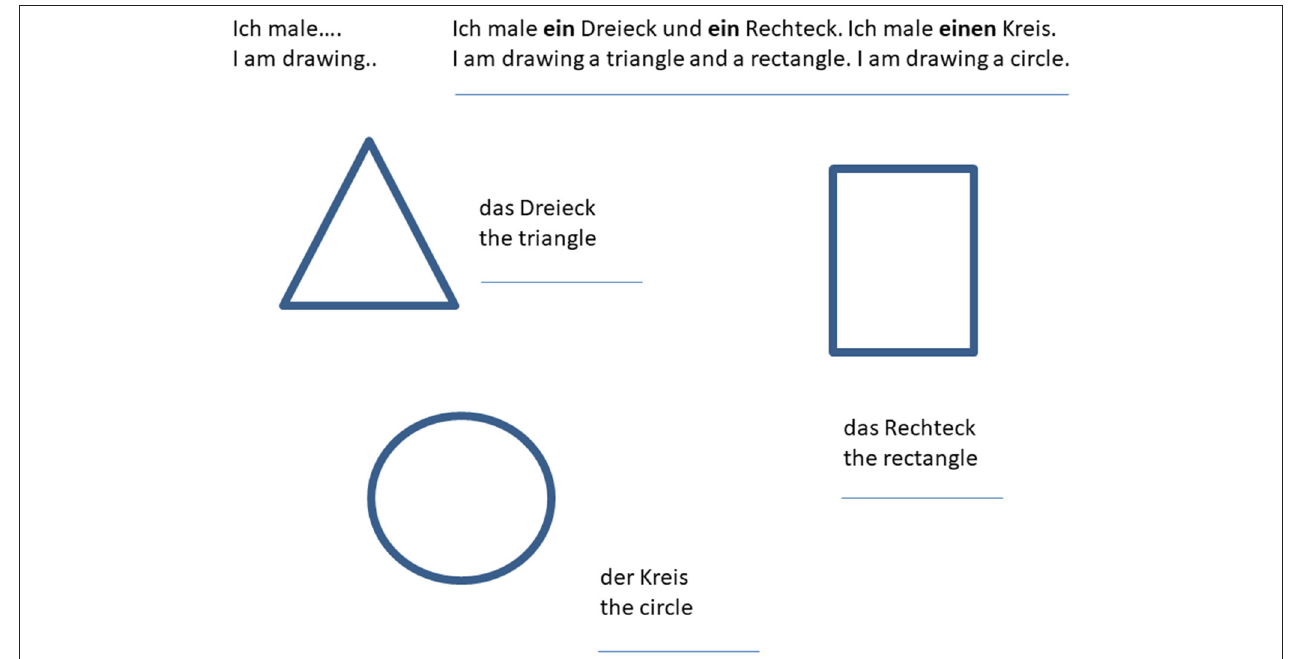
FIGURE 1 | Example of a worksheet: Essential geometric shapes.